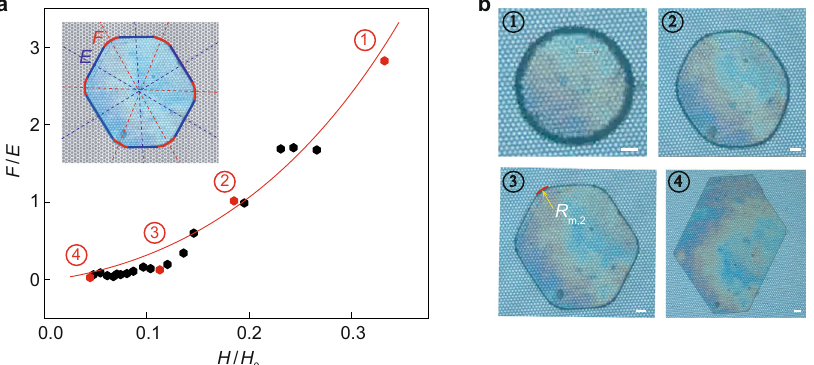
Fig. 5 Evolution of the droplet pattern on the surface with cylindrical pillars. The pillars are arranged in hexagonal patterns. The diameter of the cross- sectional area, the spacing and the height of the cylindrical pillars are 17.4 μ m, 7.6 μ m and 90 μ m, respectively. a Relationship between F / E and H / H 0 , where H 0 = 318 μ m and V 0 = 23 nl. The inset de fi nes the contact line lengths of the side ( E , blue color) and corner ( F , red color) of the droplet. The dots represent the experimental data, and the red curve is the theoretical results obtained by Eq. (4). b Selected images with four different values of H , corresponding to H = 106 μ m, 59 μ m, 36 μ m, and 14 μ m, respectively. The experimental data of the four images in ( b ) are marked in red in ( a ). Scale bar, 100 μ m. Source data are provided as a Source Data fi